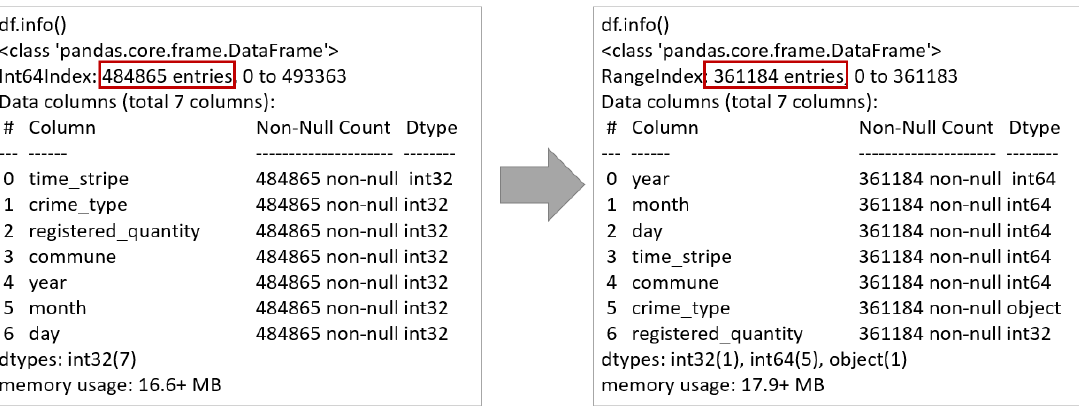
Figure A2. Result of the execution of df.info(). Source: Own elaboration.